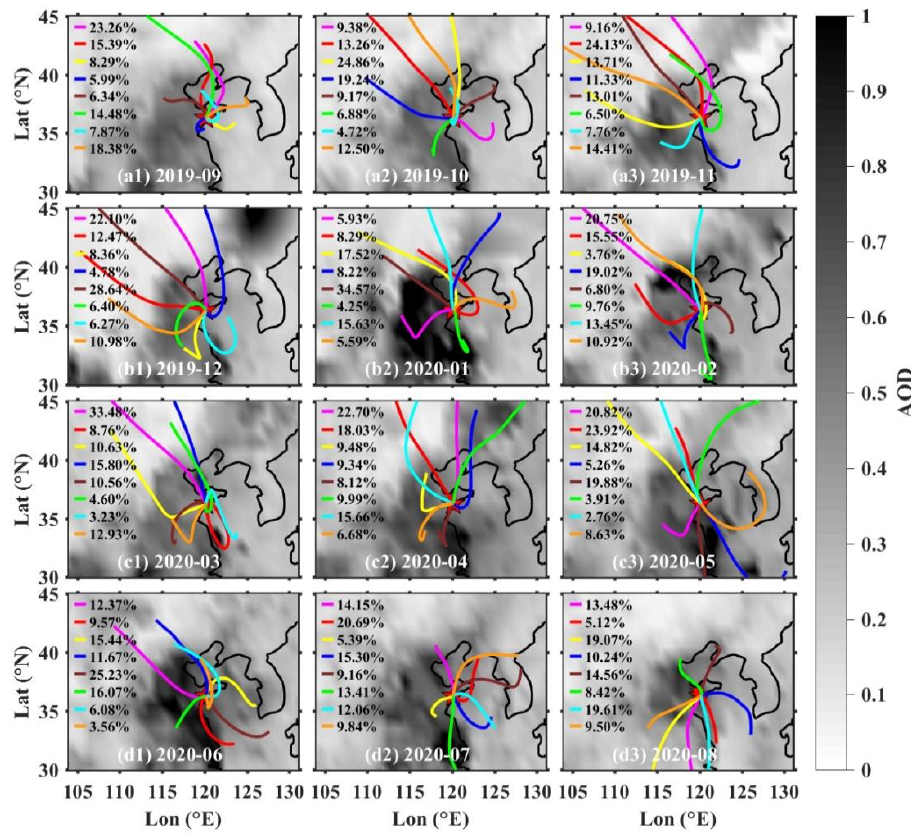
Figure 5. Cluster results from September 2019 to August 2020 in Qingdao.